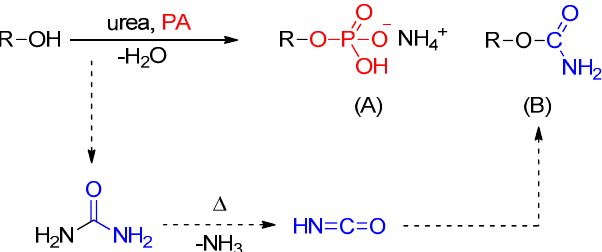
Figure 1. Reaction scheme for the functionalization of starch (R) with phosphate agents (PA) in urea; ( A ) esterification yielding mainly monoammonium phosphate compounds, ( B ) formation of carbamate groups by the side reaction with isocyanic acid from urea decomposition.